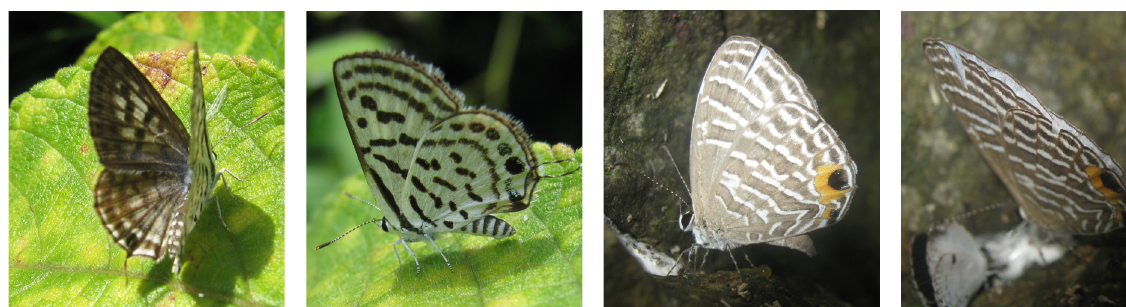
Image 10. Pointed Pierrot Tarucus theophrastus indica , female